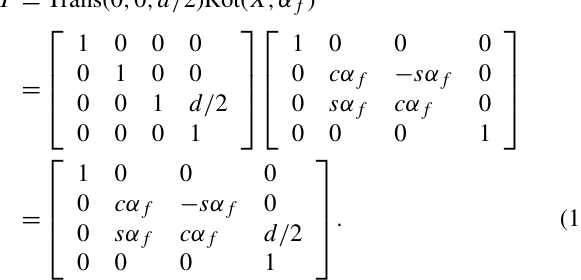
movements of the other joints behind joint i but primarily controlled the change in the rotation angle for this joint.